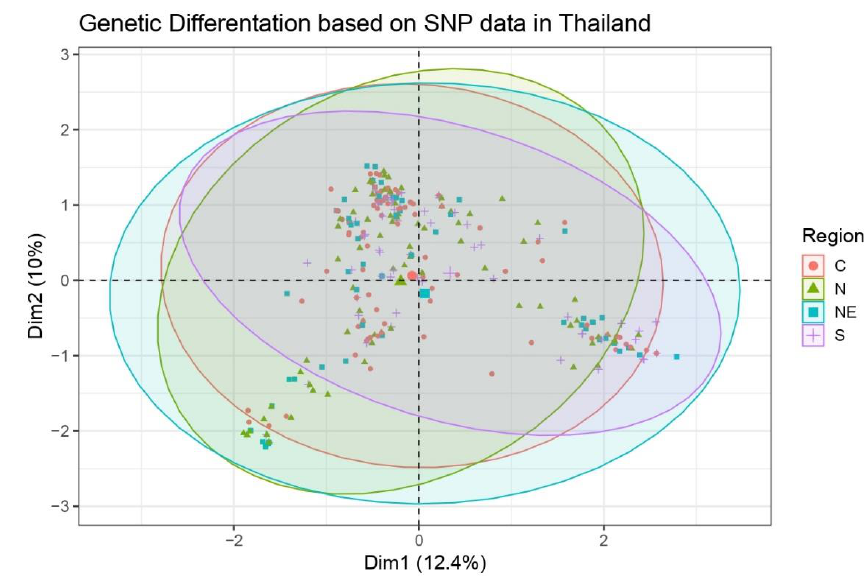
Figure 1. Genetic differentiation based on SNP data in Thailand.